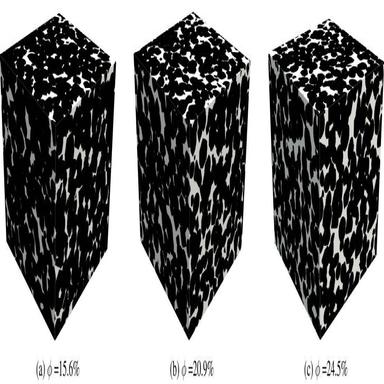
Schematic diagram of microstructure characterization and reconstruction using three-level approach.